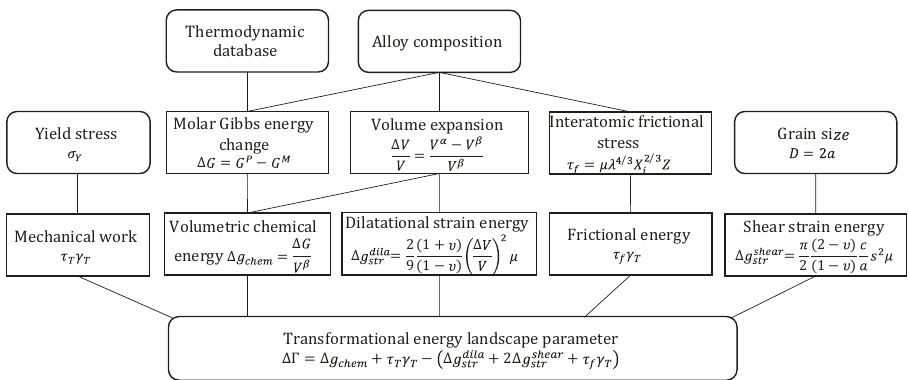
Fig. 6 Work fl ow for the calculation of transformation energy. The landscape parameter ΔΓ captures the threshold energy to trigger the